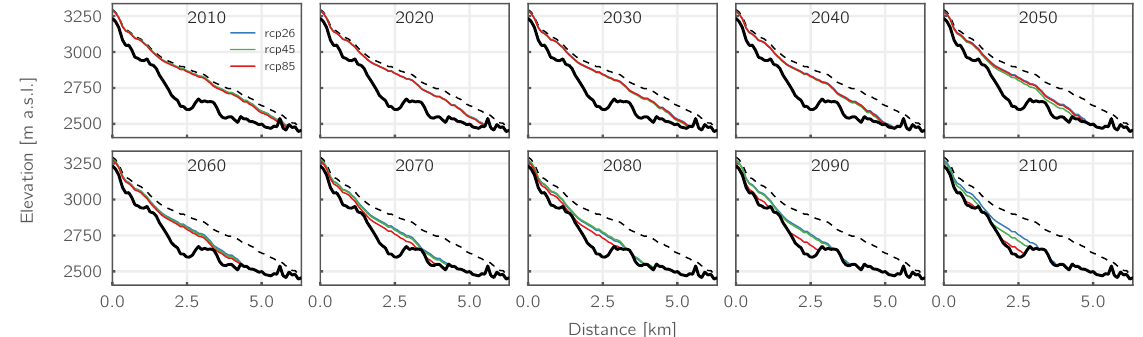
Figure 12. Bedrock topography (thick black lines) and simulated glacier thickness (thin colored lines) along the centerline of Hintereisferner as simulated for a single GCM–RCM combination (REMO2009 driven by MPI-ESM-LR) and the three RCPs, shown in 10-year intervals. Dashed black lines indicate the initial ice thickness as of the year 1997.